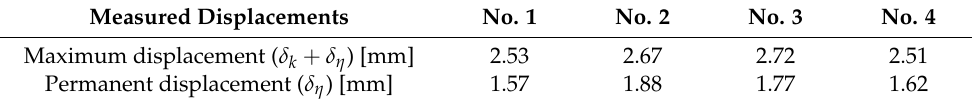
Figure 11. Maxwell model in creep and recovery. Table 6. Displacement due to linear spring and linear viscous dashpot effect of TFR-CV specimen. Measured Displacements